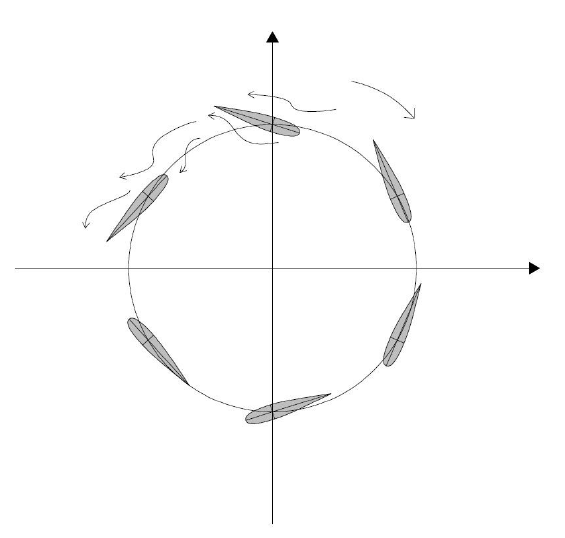
Figure 7. Interference phenomena